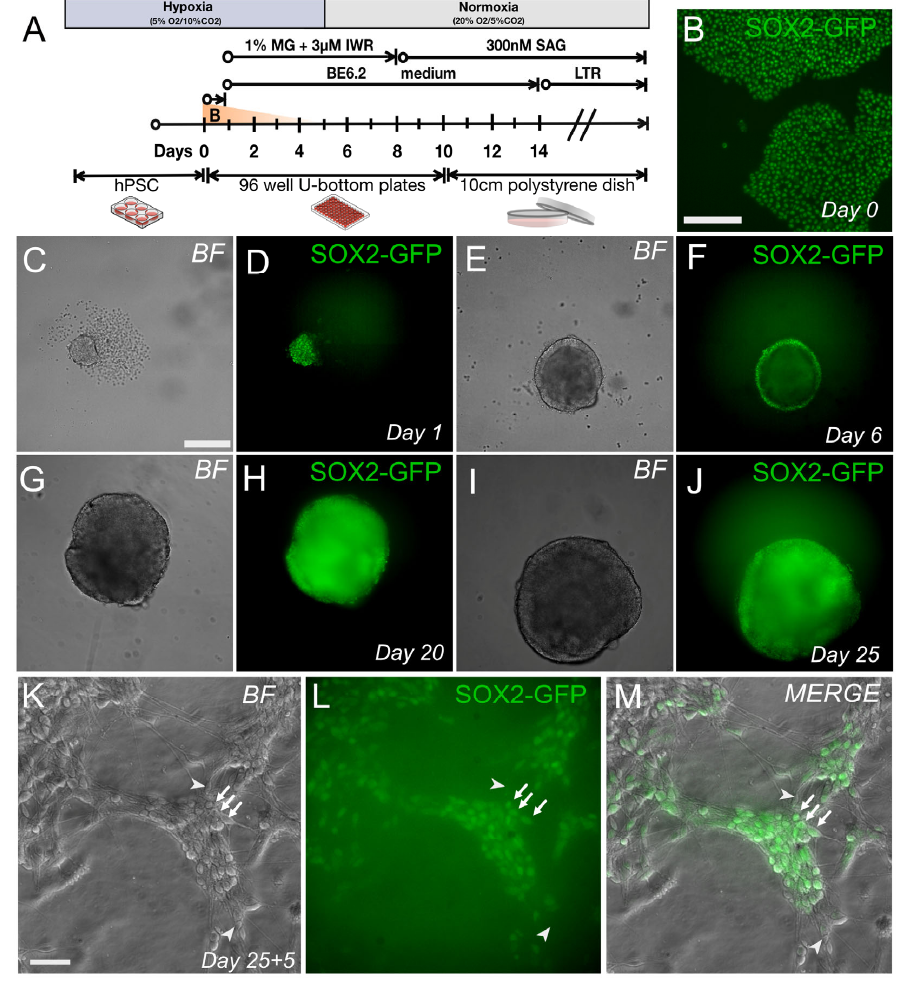
Figure 4. Differentiation potential of gene-edited SOX2-GFP IMR90.4 iPSCs. ( A ) SOX2-GFP integrated organoids were differentiated using a standard retinal organoid differentiation protocol. ( B ) IMR90.4 ‐ HF ‐ iCas9 SOX2 ‐ GFP PSCs expressing GFP from the endogenous SOX2 gene. ( C – J ) Devel ‐